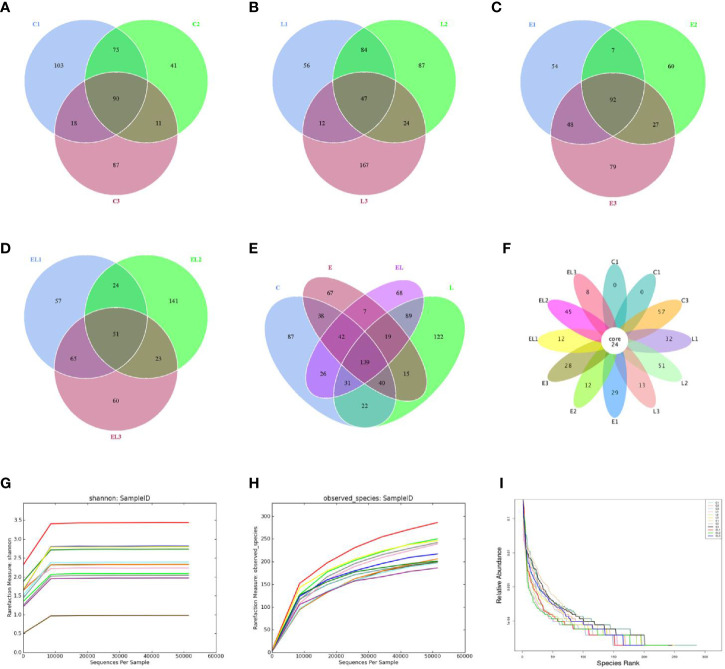
Venn diagrams and sample feasibility analysis. Venn diagrams for bacterial OTUs compositions in C (A), L (B), E (C) and EL (D) groups. (E) Venn diagram for unique and shared bacterial OTUs in four groups. (F) Venn diagrams for core OTUs compositions. The rarefaction (G) and species accumulation curve (H) and rank abundance curve (I) were used to assess the adequacy, evenness and richness of sequencing of each sample. Each curve with a different color shown in the figures indicates a sample.